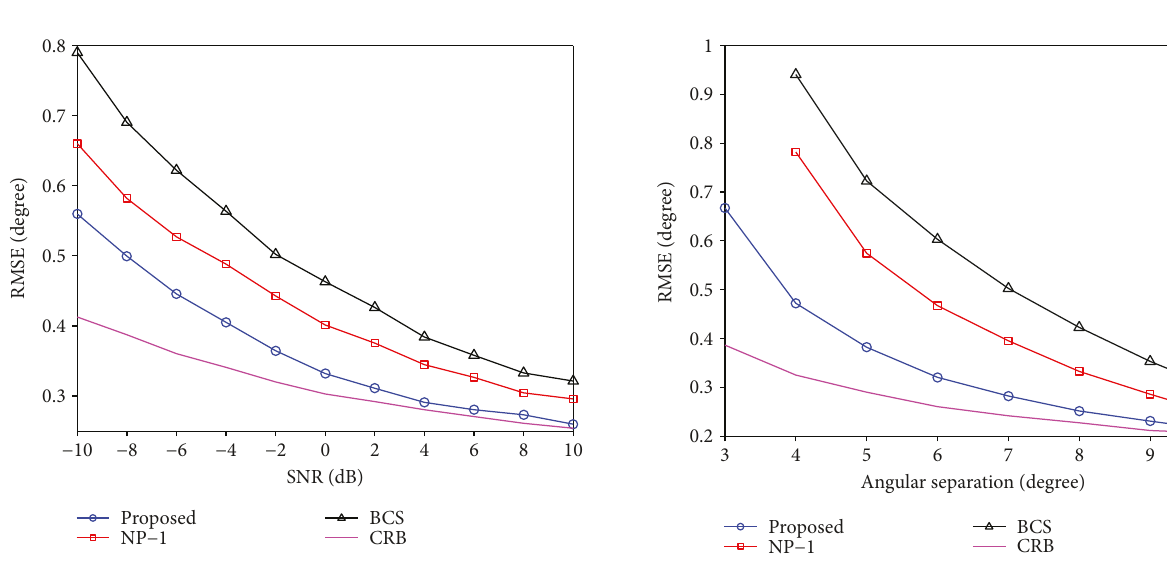
Figure 9: RMSE versus angular separation with the fi xed SNR 10dB and number of snapshots 500 for coherent